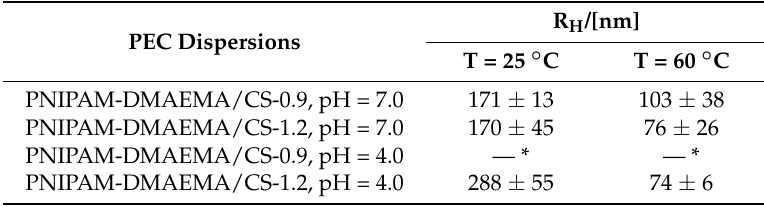
Table 3. Hydrodynamic radii (R H ) of PNIPAM-DMAEMA/CS complex dispersions (0.01 M) for n − /n+ = 0.9 and 1.2 at pH = 7.0 and 4.0 at T = 25 and 60 ◦ C obtained by DLS.